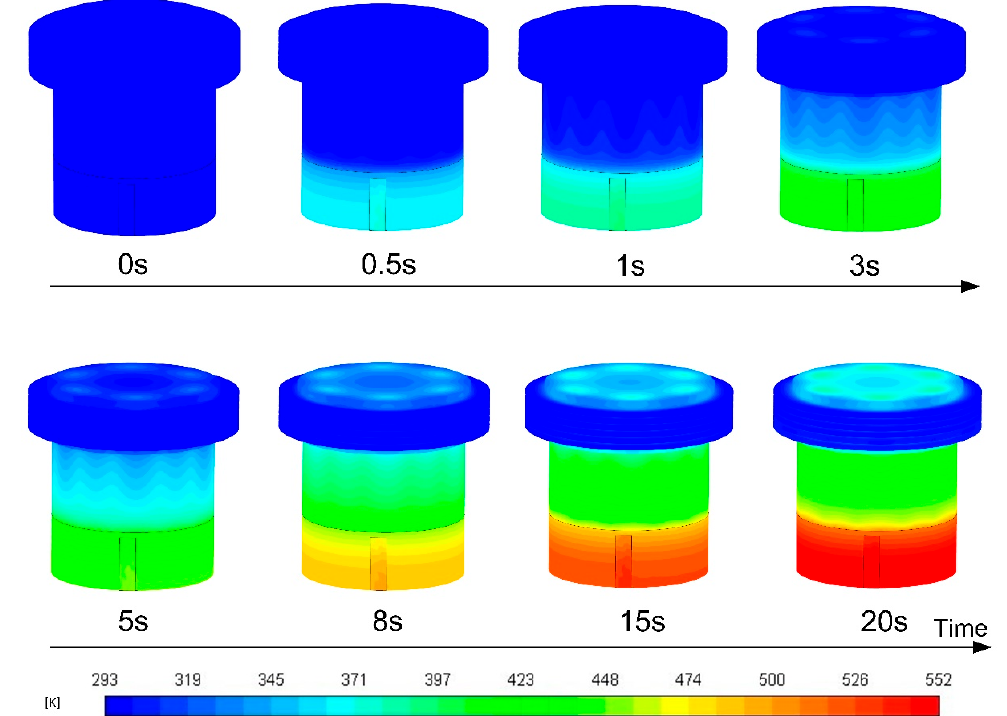
Figure 11. Changes of temperature on the grinding wheel with 6 OHPs (Temperature unit: K).